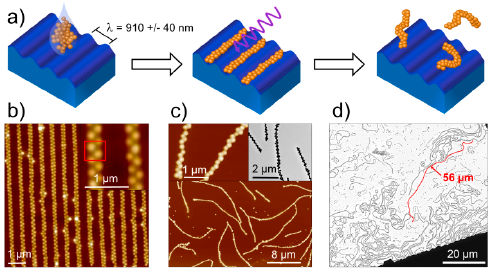
Figure 1. Sample preparation scheme and corresponding AFM and TEM images: ( a ) alignment of microgels (represented by orange spheres) in the wrinkle grooves (blue trenches) via spin-coating, UV irradiation (wavy arrow) of microgel assemblies and redispersion of cross-linked microgel assemblies; ( b ) AFM image of microgels aligned in a zigzag formation within the wrinkle grooves and magnification of the microgel overlap; ( c ) AFM and TEM images of redispersed microgel chains transferred onto a substrate (Si wafer and TEM grid, respectively); and ( d ) TEM image of microgel chains; maximum lengths are beyond 50 μ m.